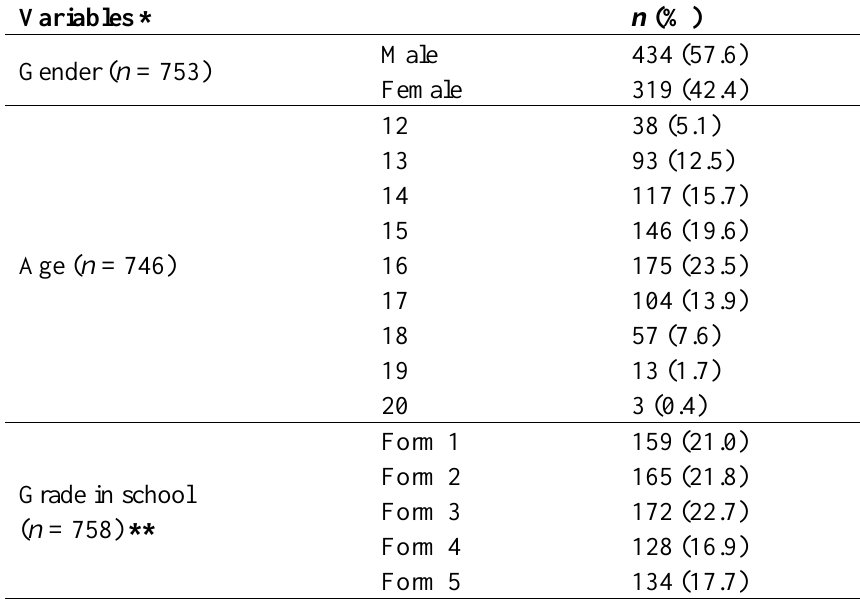
Table 1. Descriptive Statistics of the Participants ( n =